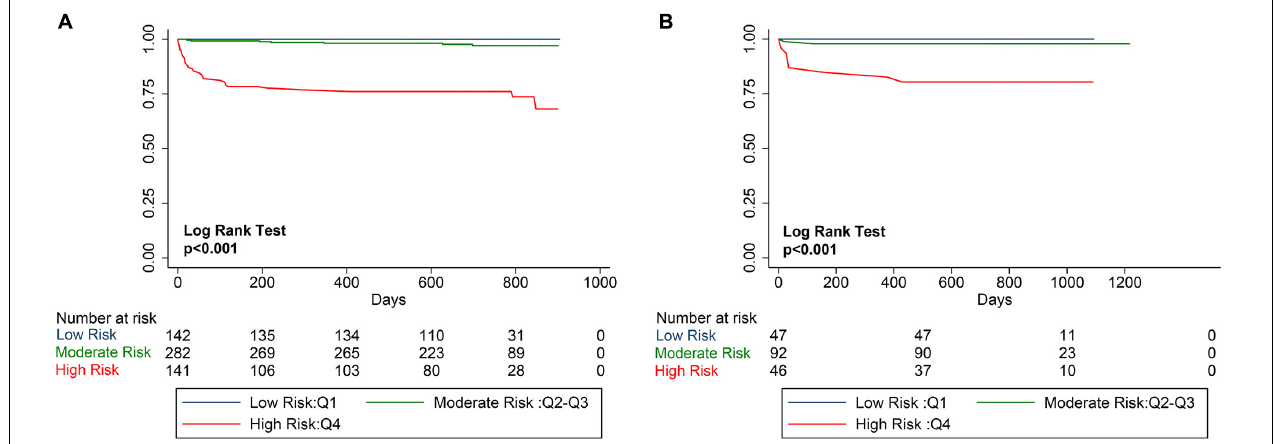
FIGURE 5 | Kaplan–Meier Estimates of mortality for internal validation cohort and external verification cohort. The survival rate was observed using the Kaplan–Meier curve and compared using the log-rank test. (A) Kaplan–Meier estimated the survival rate of the internal validation cohort using the PRIME score. (B) Kaplan–Meier estimated the survival rate of the external validation cohort using the PRIME score. As shown by the Kaplan–Meier curve, the two cohorts showed significant differences in mortality among the three risk score groups ( P <